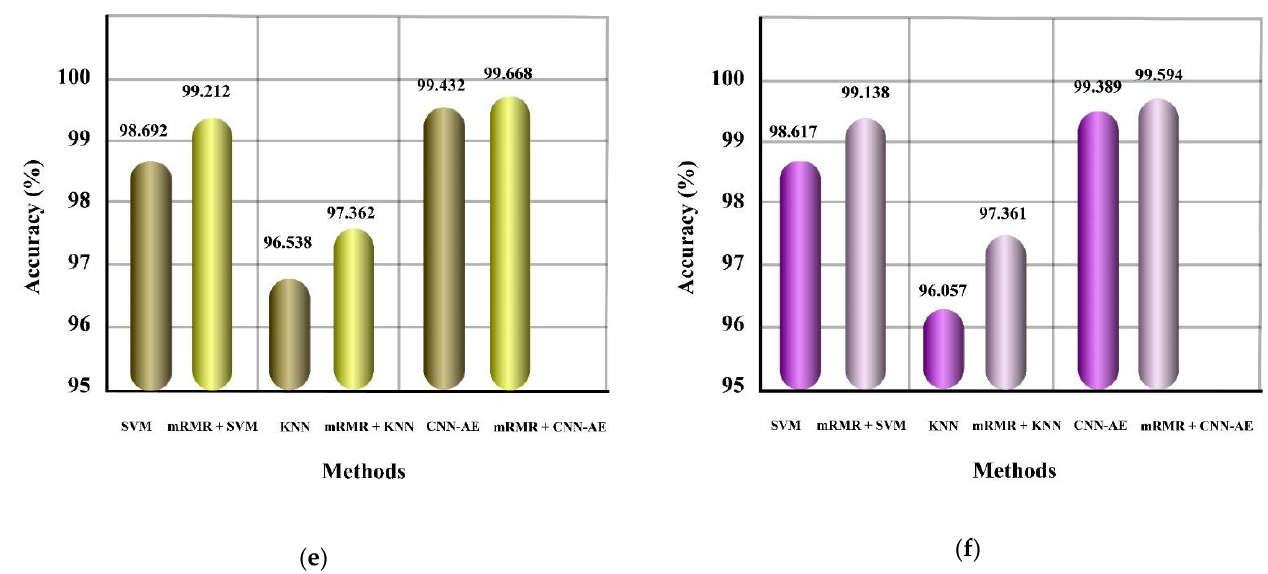
Figure 7. Results for the Bonn Dataset. ( a ): set A-E, ( b ): Set B-E, ( c ): set C-E, ( d ): set D-E, ( e ): set ABCD-E, ( f ): set AB-CD-E. Table 9. Results of proposed method for the Freiburg dataset.